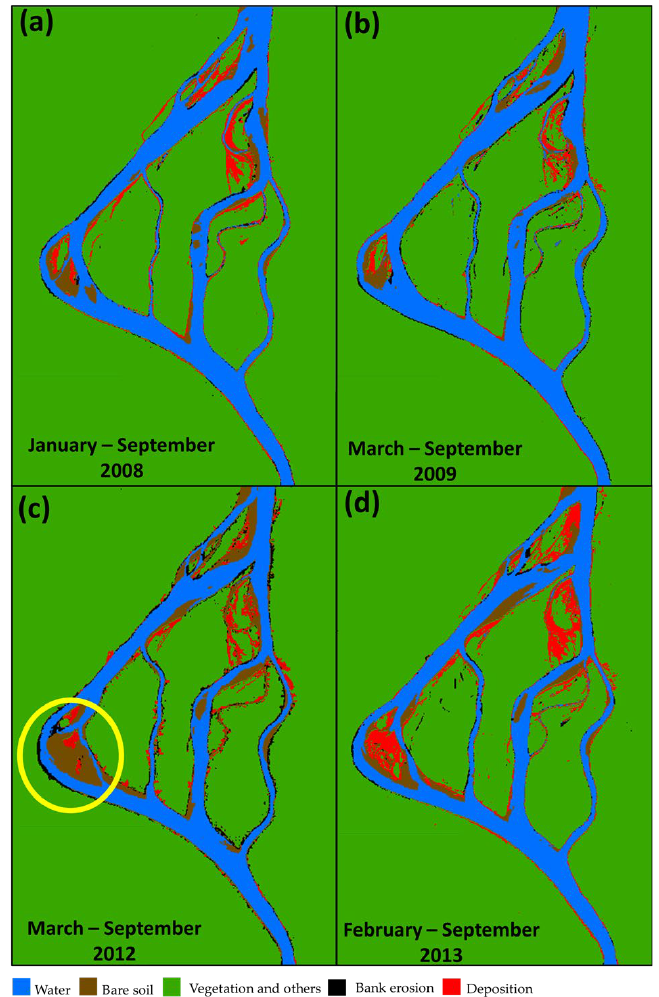
Figure 7. Figure ( a ) 2008, ( b ) 2009, ( c ) 2012 and ( d ) 2013 represent the bank erosion and deposition between the wet and dry seasons in the Muyuy anabranching area. In this map, (1) black color: bank erosion areas, (2) blue color: water areas, (3) brown color: bare soil areas, (4) red color: deposition occurred, and (5) green color: vegetation and others. The bank erosion and deposition were relatively consistent in 2008 and 2009. The yellow circle shows the high erosion area in the flooding year of 2012.